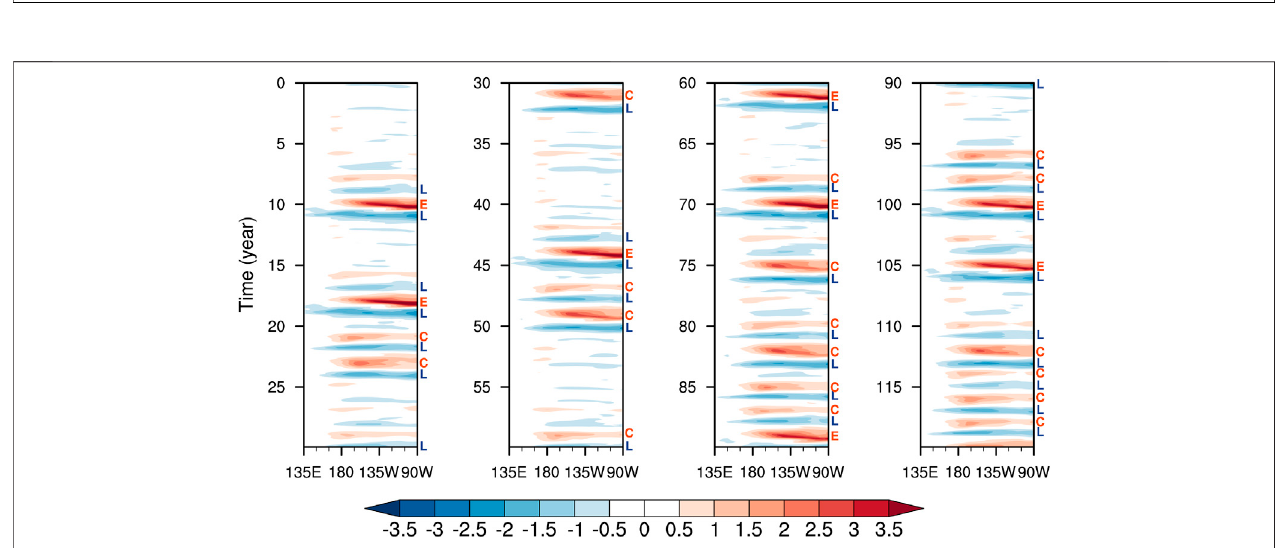
FIGURE 10 | Hovmöller diagram of 120-year RCZ simulated equatorial (5 ° S – 5 ° N average) SSTA (unit: ° C). The 120-year segment of data is from the 5000-year simulation and is separated into four consecutive 30-year segments for display. The type of each ENSO event is indicated on the right-hand-side of the Hovmöller diagram, with red “ E ” denoting EP El Niño, red “ C ” denoting CP El Niño, and blue “ L ” denoting La Niña.